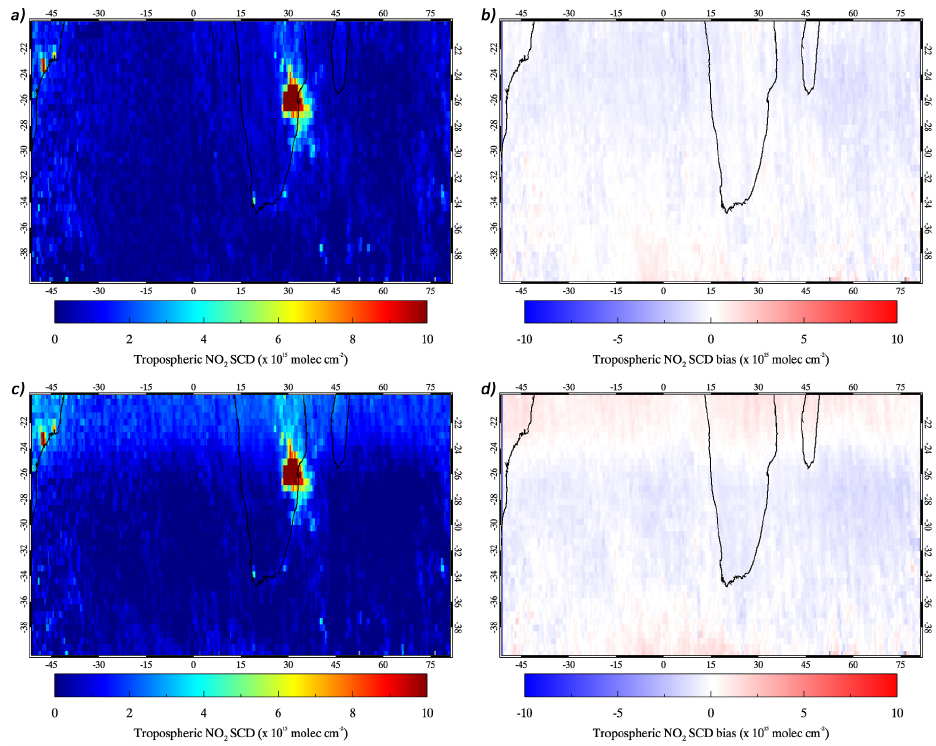
Figure 10. Comparison of tropospheric NO 2 SCDs retrieved over South Africa (20–40 ◦ S, 50 ◦ W–80 ◦ E) using Pacific and South Atlantic reference spectra with DOMINO. (a) Average tropospheric NO 2 SCD retrieved using a S. Atlantic Earth radiance reference. (b) Average bias between S. Atlantic Earth radiance retrieval and DOMINO tropospheric SCD. (c) Average tropospheric NO 2 SCD retrieved using a Pacific Earth radiance reference spectrum. (d) Average bias between Pacific Earth radiance retrieval and DOMINO tropospheric SCD.